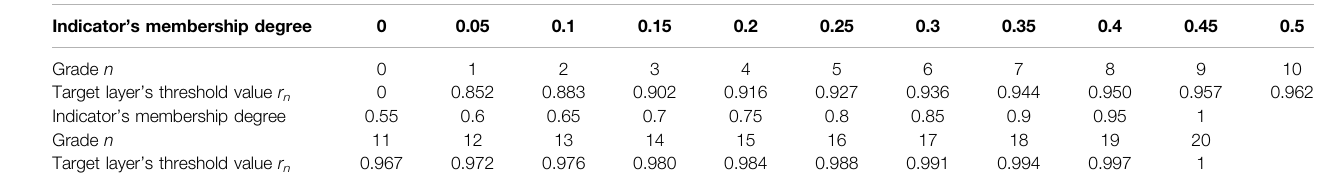
TABLE 3 | Re fi ned grade scale of comprehensive assessment